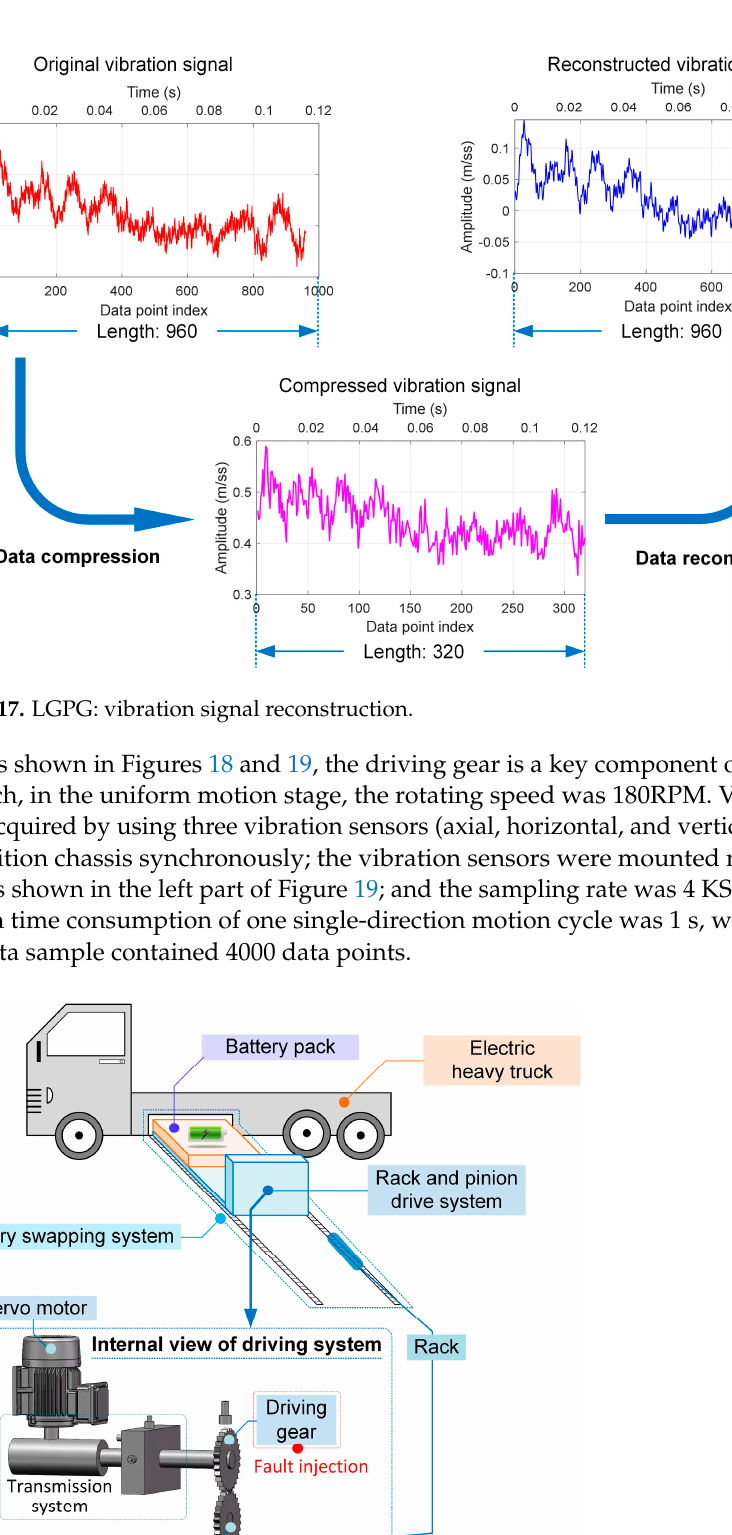
Figure 18. Structure of battery swapping system.